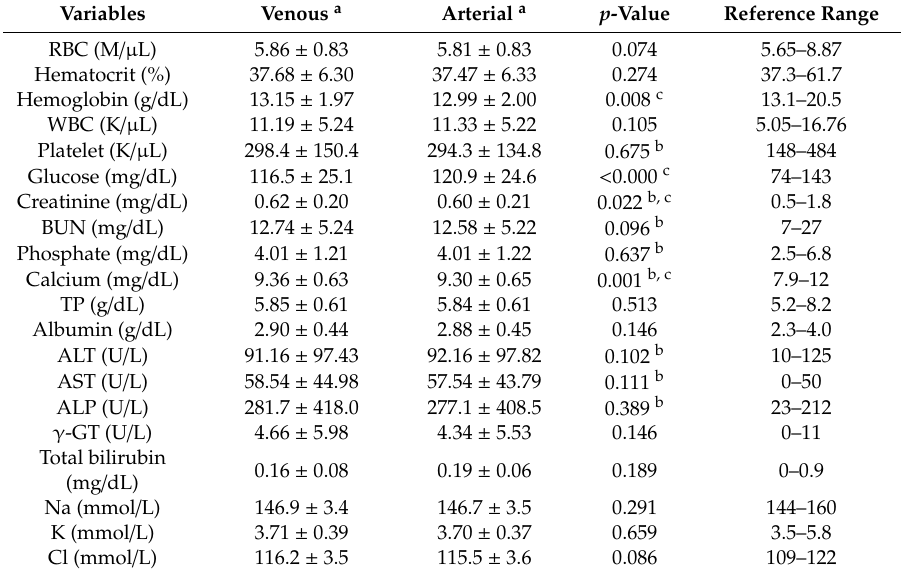
Table 2. Comparison of hematological and biochemical results collected from arterial and venous